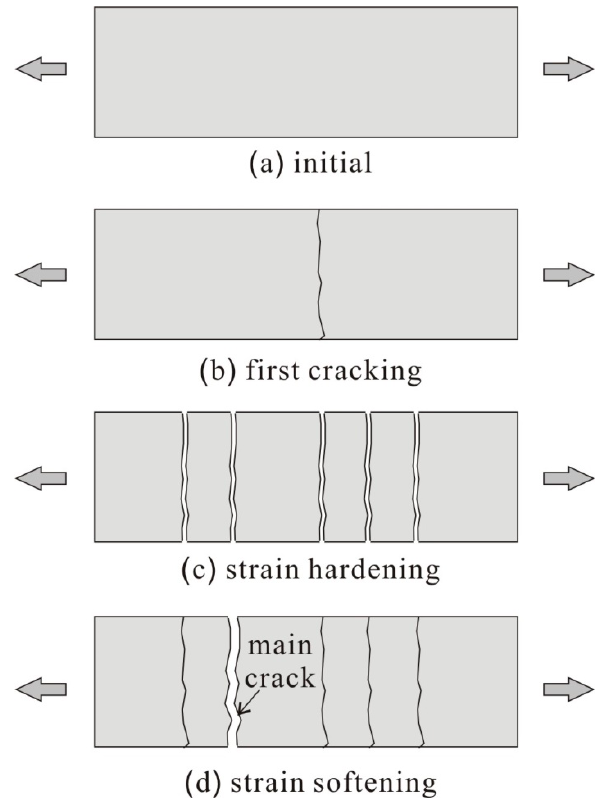
Figure 2. Cracking pattern of HPFRC subjected to tension. ( a ) initial; ( b ) first cracking; ( c ) strain hardening; ( d ) strain softening.